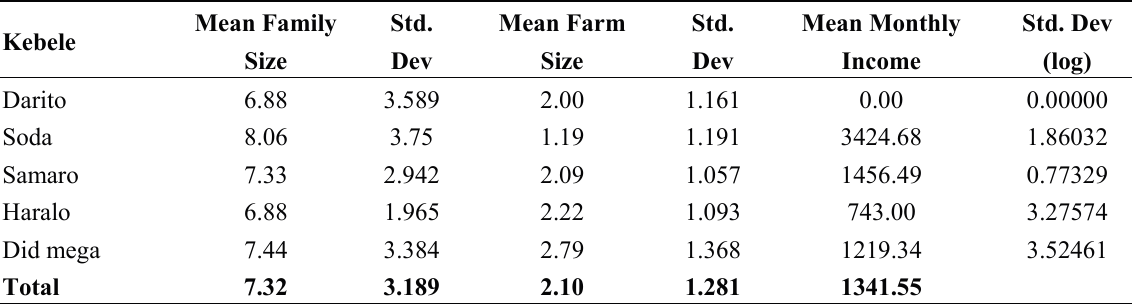
Table 4. Comparison of mean family size, land size, and income across the study sites (at the time of this research 1 US$~17.7 Ethiopia Birr): The mean monthly income is indicated in Ethiopia Birr